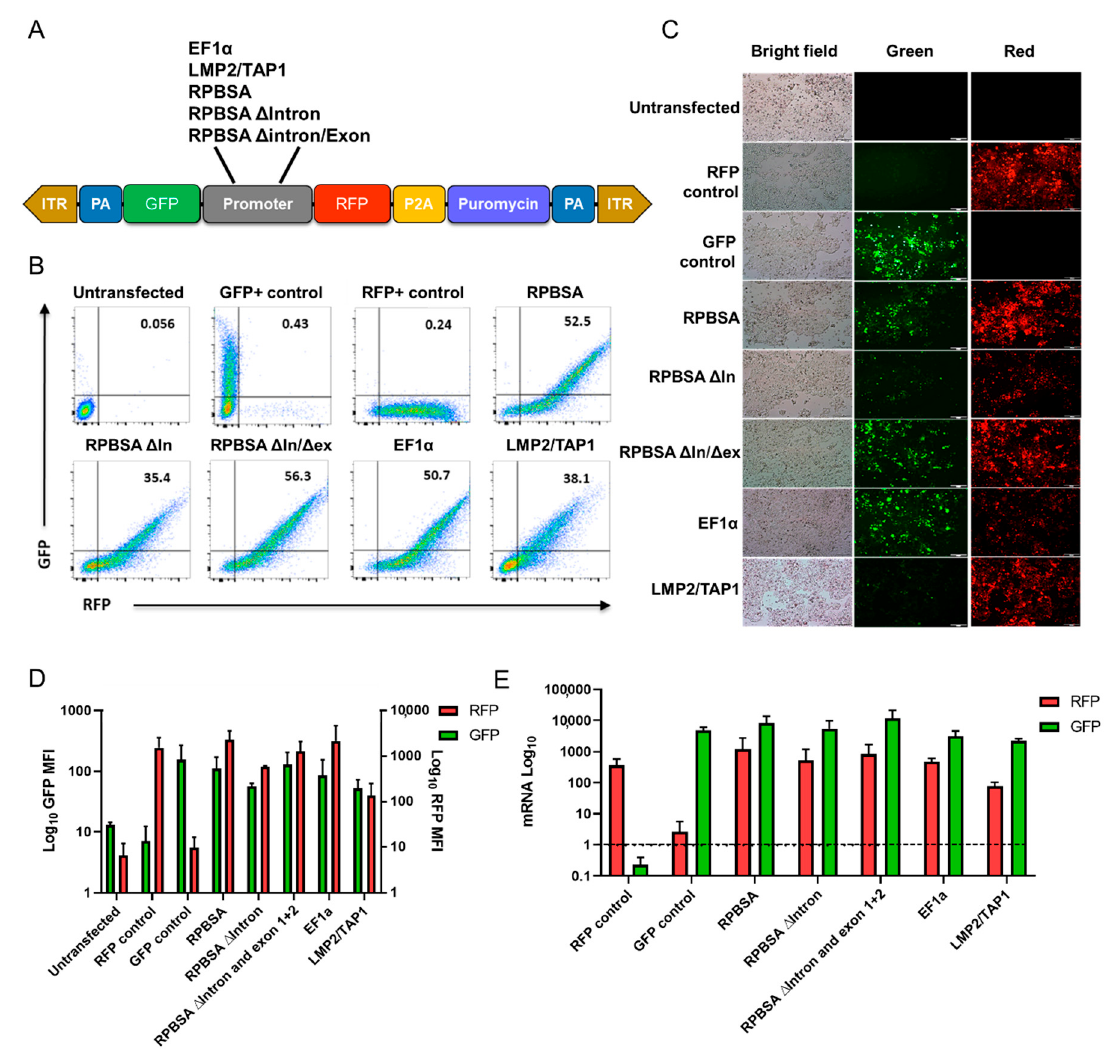
Figure 1. Determination of bidirectional activity promoters in HEK293T. ( A ) Schematic illustration of the Sleeping Beauty backbone bearing five promoters (EF1 α , LMP2/TAP1, RPBSA WT, RPBSA Δ Intron, RPBSA Δ Intron/Exon) for driving RFP ‐ P2A ‐ Puromycin expression . T cells. Cells were subjected to FSc and SSc doublet discrimination. ( B , C ) Flow cytometric analysis and fluorescence microscopy of HEK293T cells expressing green and red fluorescent proteins (GFP and RFP). ( D ) Assessment of the mean fluorescence intensity (MFI ) of GFP and RFP expression for each promoter. ( E ) Genomic DNA was extracted from cell lysates of Sleeping Beauty transposed HEK293T and qPCR was performed using GFP and RFP primers and β -actin as a housekeeping gene. Data are representative of two to three experiments performed.